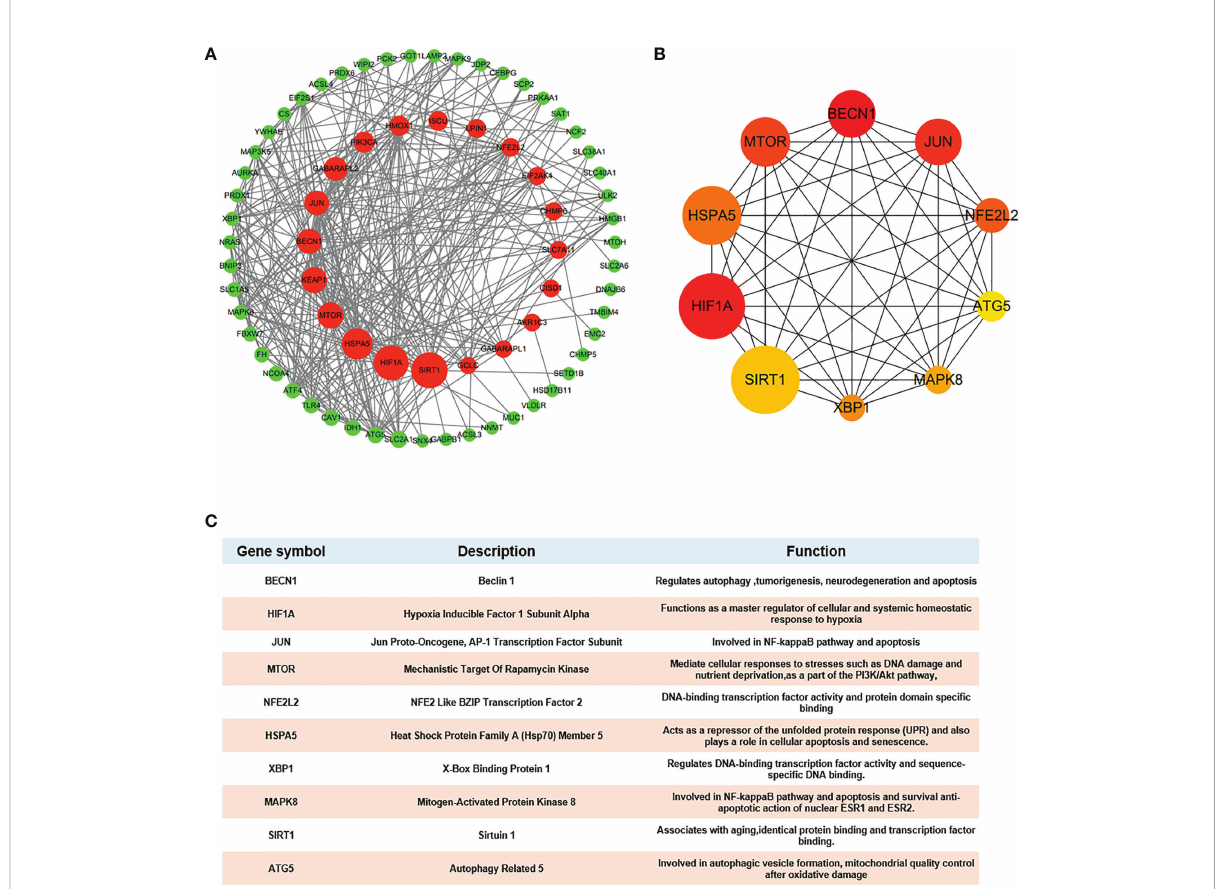
FIGURE 5 Hub gene identi fi cation (A) DEG PPI network constructed using Cytoscape, top 20 genes were shown inside the circle, genes were ranked by size according to Betweenness Centrality (BC) score. (B) Top 10 genes with the highest degree values were identi fi ed using CytoHubba and the depth of the color correspond to the weighted score. (C) The description and function of 10 hub genes were shown in